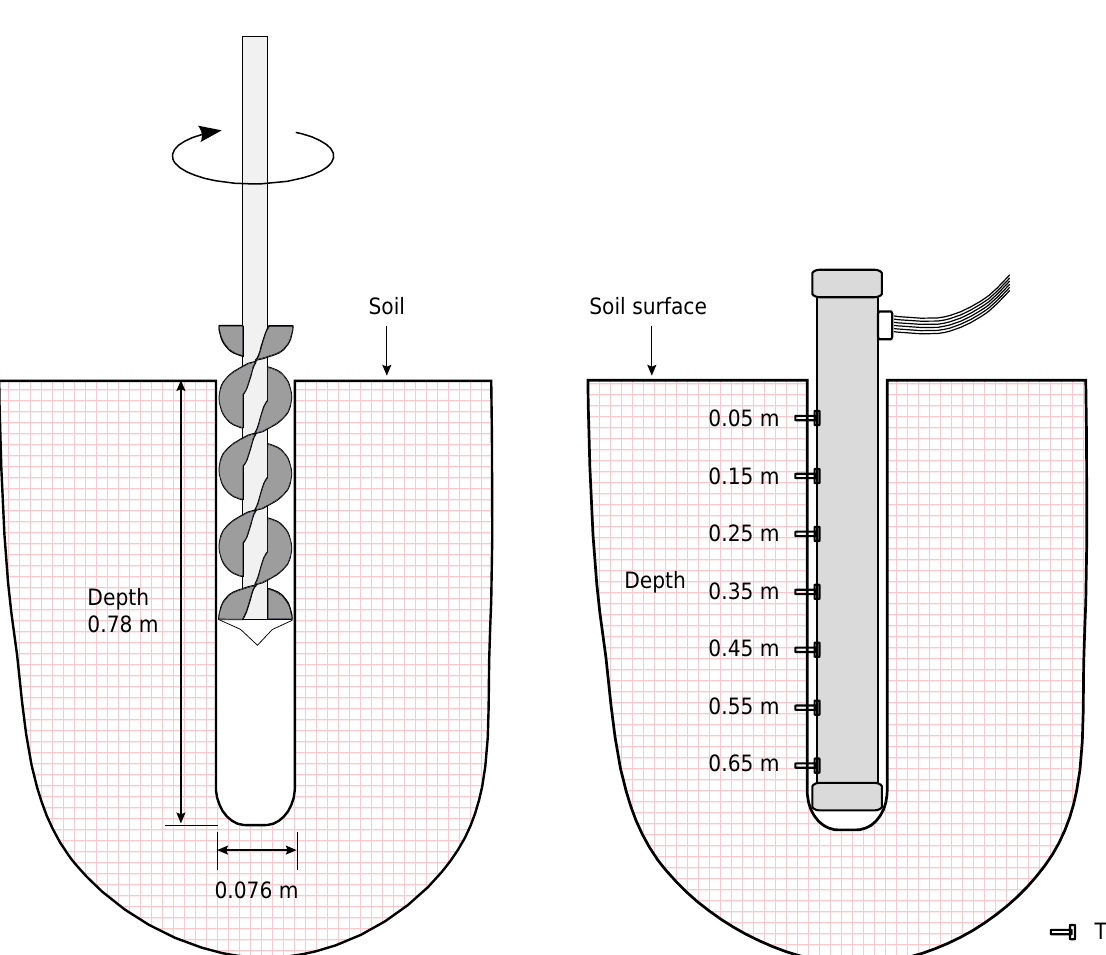
Figure 1. Scheme of well drilling by twist drill and the measuring